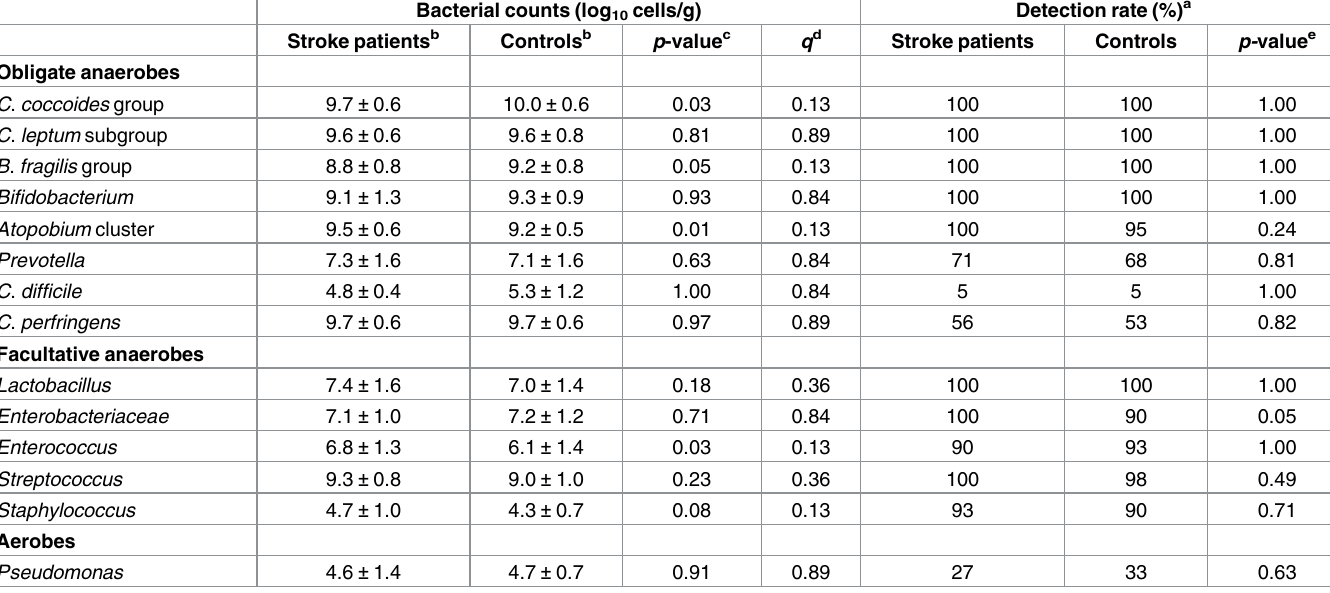
Table 2. Comparisons of fecal bacterial counts between stroke patients and control